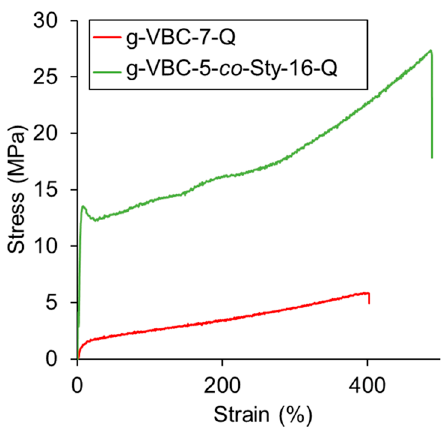
Figure 8. Stress–strain curves for SBS, g-VBC-7-Q, and g-VBC-5- co -Sty-16-Q.